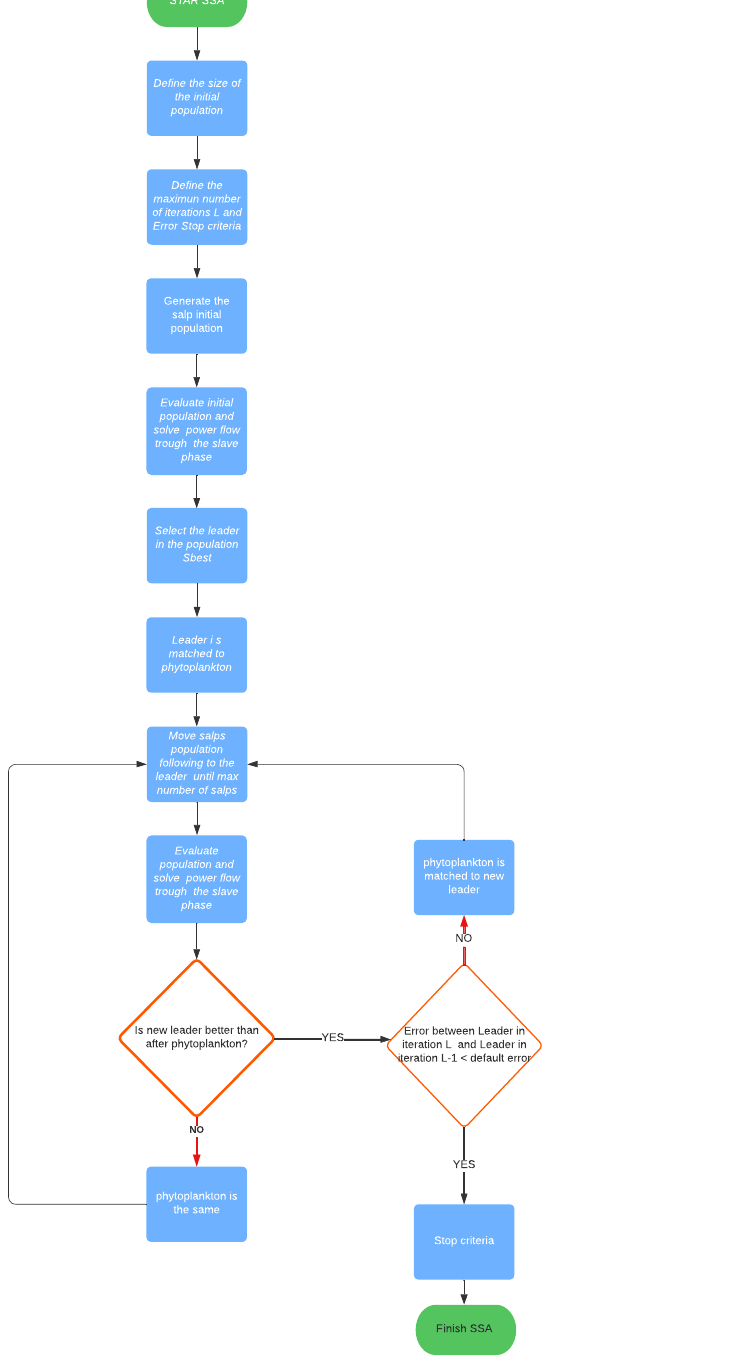
Figure 1. Flow diagram of the proposed SSA applied to the optimal location and sizing D-STATCOMs in distribution networks (See Section